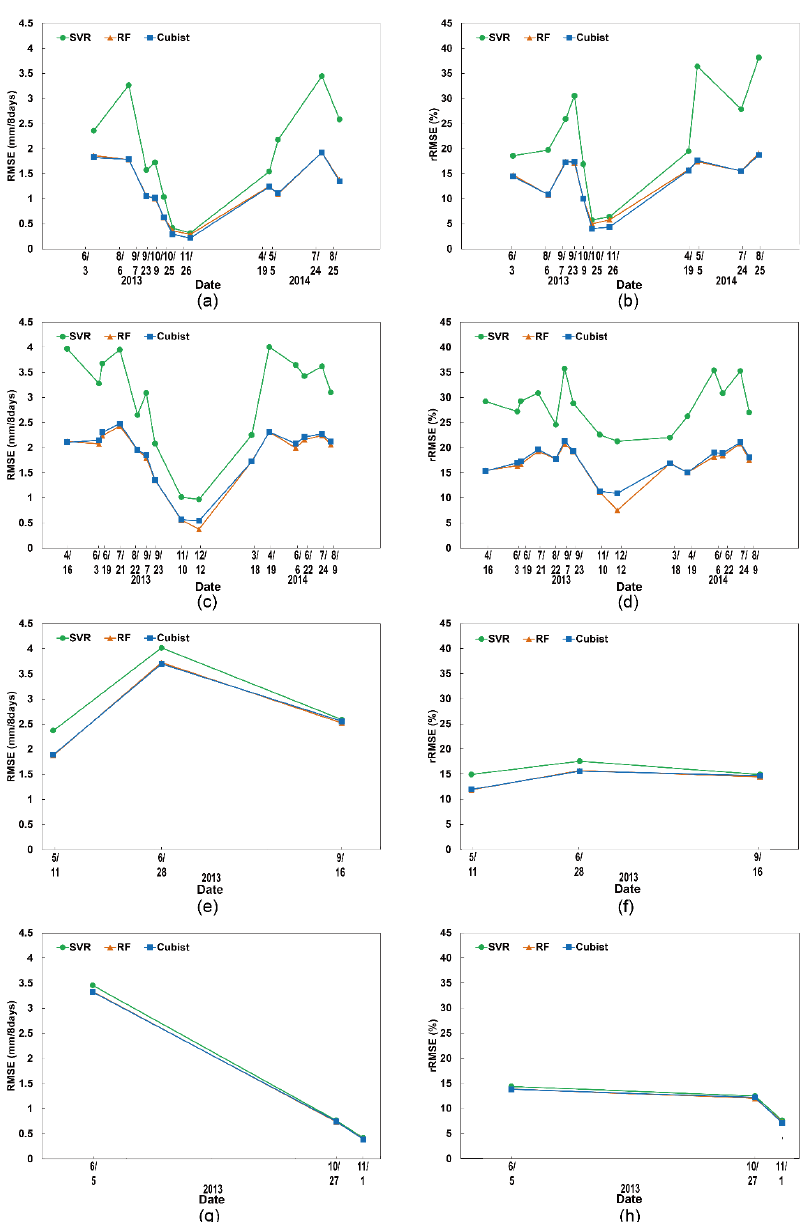
Figure 4. Root Mean Square Error (RMSE) and relative RMSE (rRMSE%) of Support Vector Regression (SVR), Random Forest (RF), and Cubist models at: Site 1 ( a , b ); Site 2 ( c , d ); Site 3 ( e , f ); and Site 4 ( g , h ).